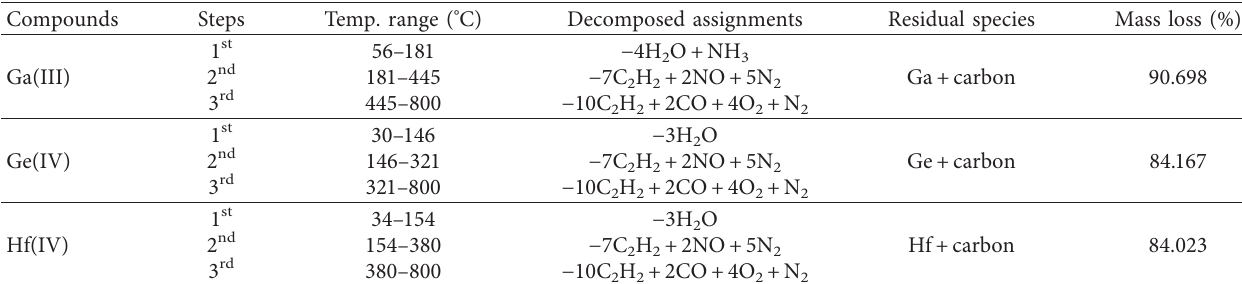
Figure 4: TGA curves of Ga(III), Ge(IV), and Hf(IV) folate complexes. Table 4: TGA decomposition data of the FAH 2 ligand and synthesized